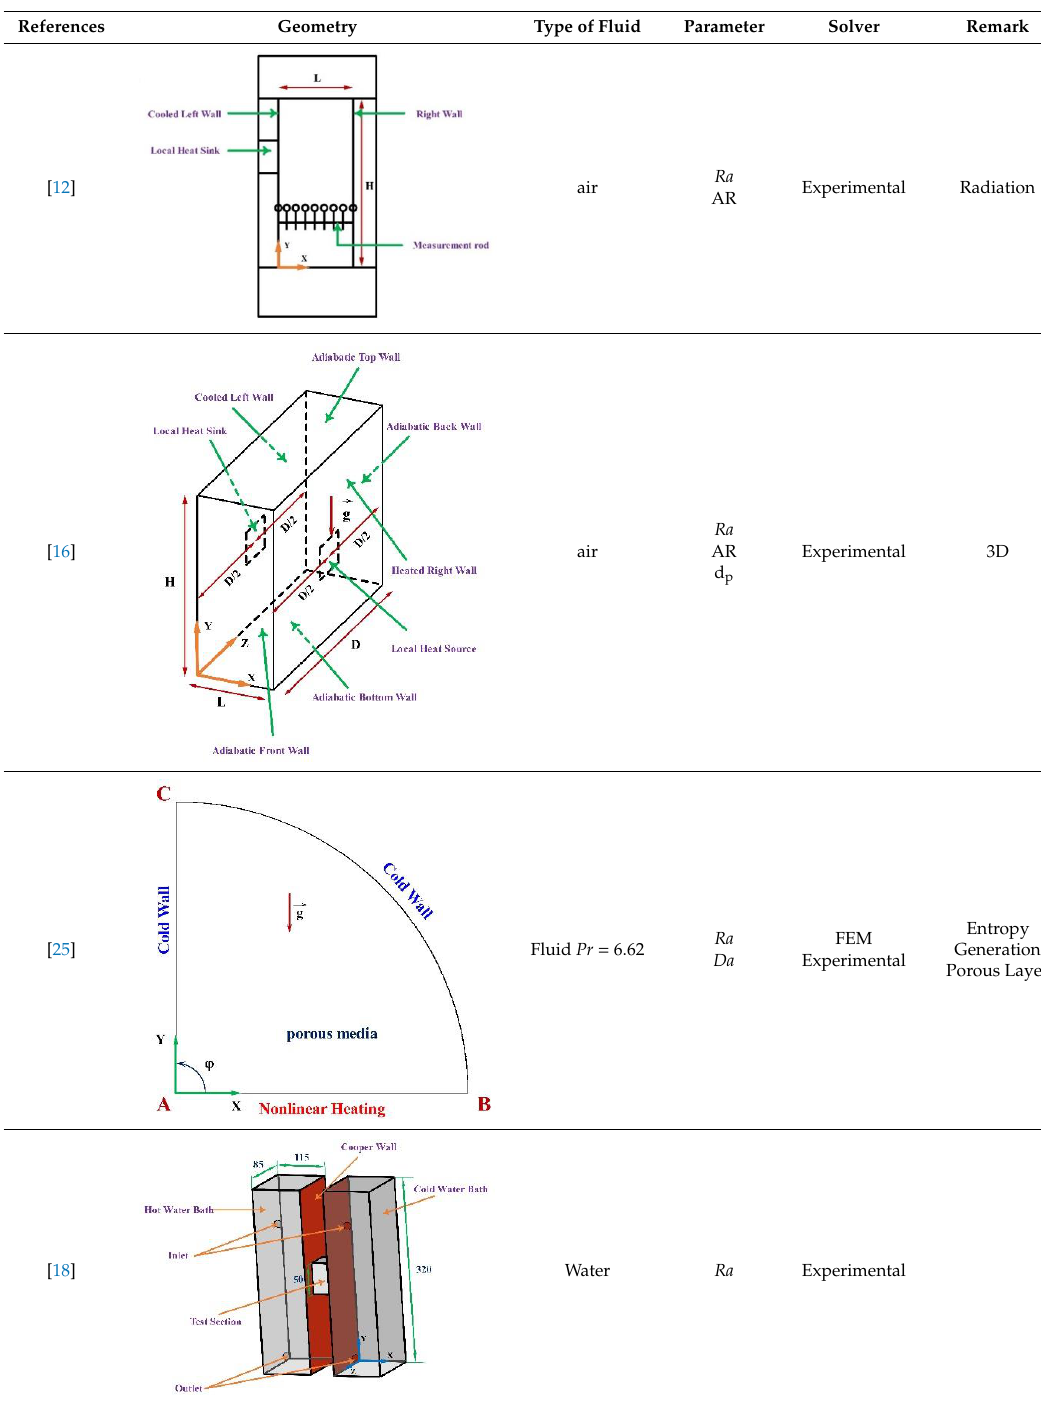
Table 1. Summary of experimental investigations performed on the enclosures.